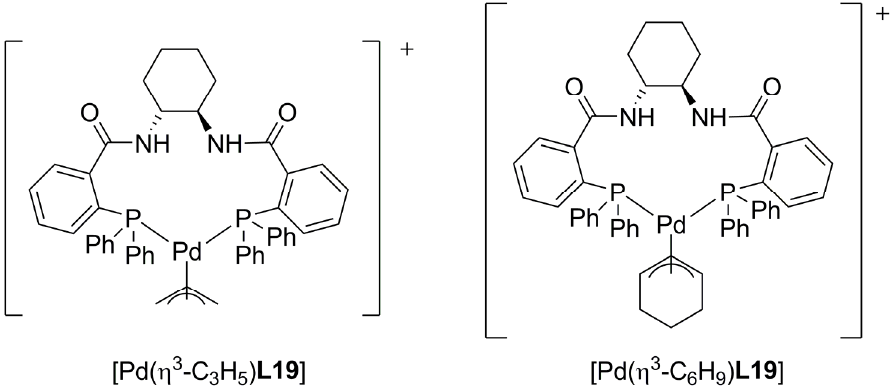
Figure 8. Cationic complexes of the ( R , R )-standard ligand studied by NMR.